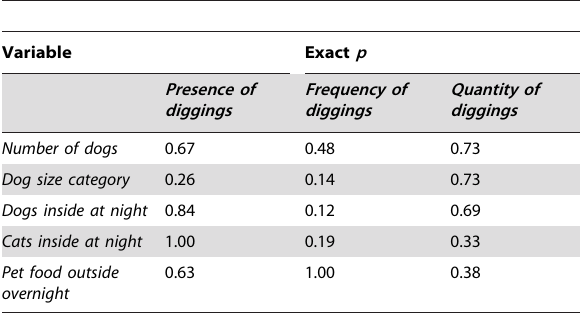
Table 1. Bandicoot activity was not affected by size, number of pets, or whether pets or food were outside overnight.